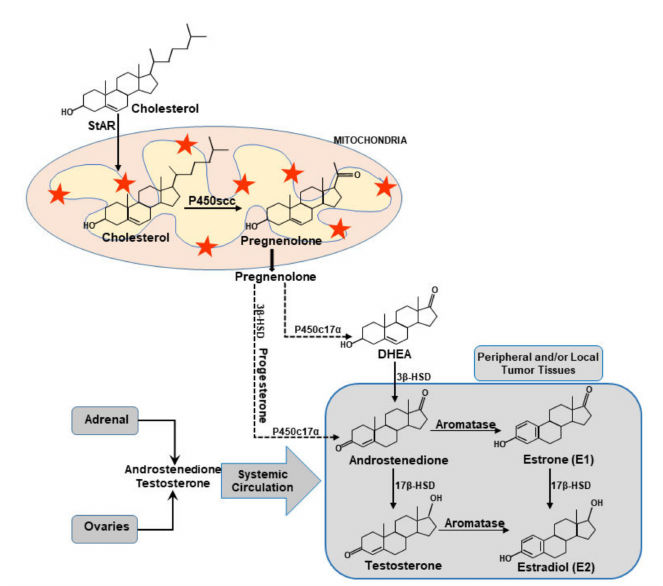
Figure 3. Steroid biosynthetic pathway elucidating peripheral and local tissue estrogen biosynthesis. Cholesterol is the substrate for all steroid hormones. The StAR protein predominantly regulates steroid biosynthesis by controlling the transport of cholesterol from the outer to the inner mitochon- drial membrane. At the inner mitochondria, the first steroid, pregnenolone, is formed by the action of the cytochrome P450scc enzyme. Pregnenolone exits the mitochondria and it is then converted to various steroid hormones by tissue-specific enzymes. Aromatase is the rate-liming enzyme in the biosynthesis estrogens from androgens. The rectangle illustrates estrogen biosynthesis in peripheral and local tumor tissue. Androgens synthesized in the adrenal gland and ovaries (pre-menopausal) are converted to estrogens through the action of the aromatase enzyme. The 17 β -HSD enzyme converts estrone to 17 β -estradiol